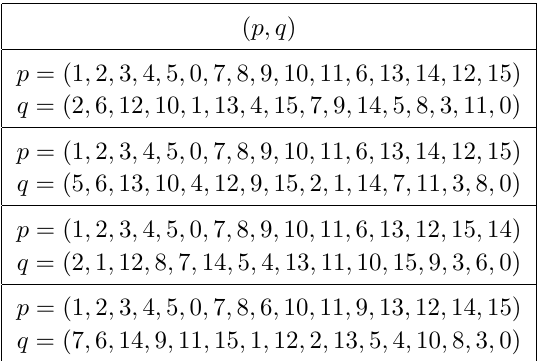
Table 3: Optimal equivalence classes with k =